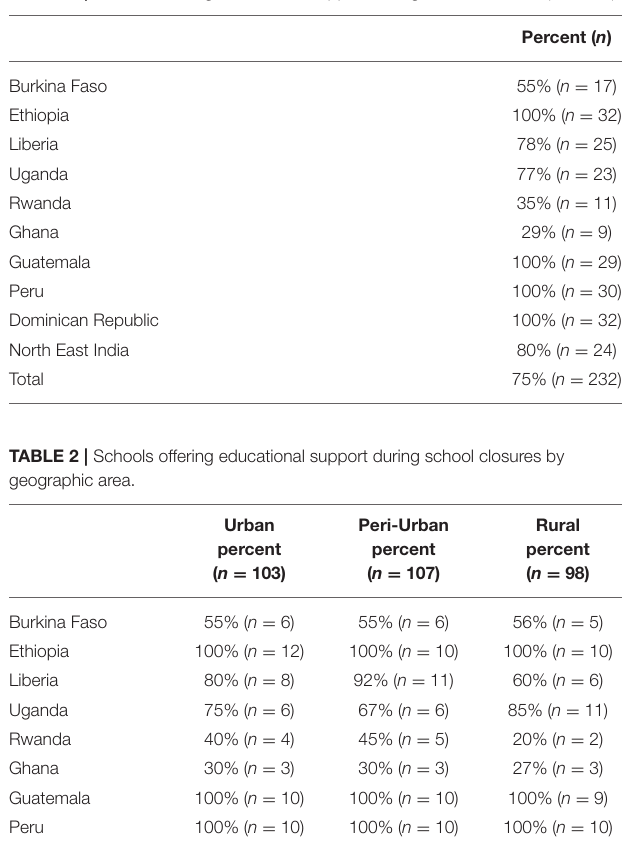
TABLE 1 | Schools offering educational support during school closures ( n =